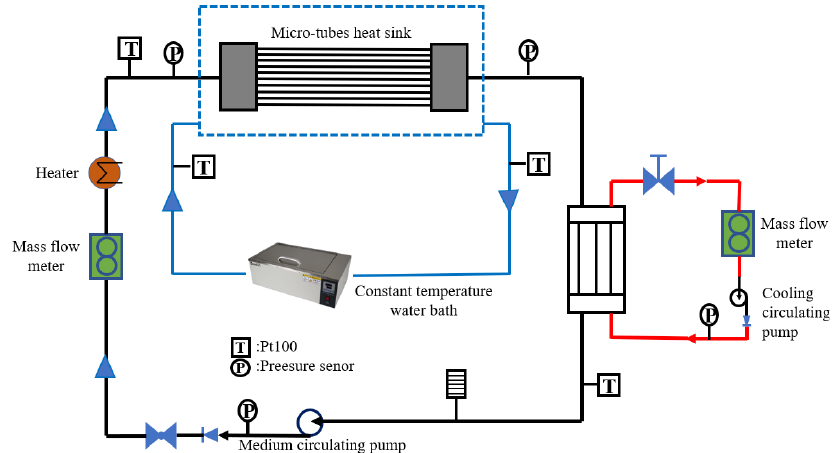
Figure 6. The outline of the long micro-tubes heat sink closed loop.